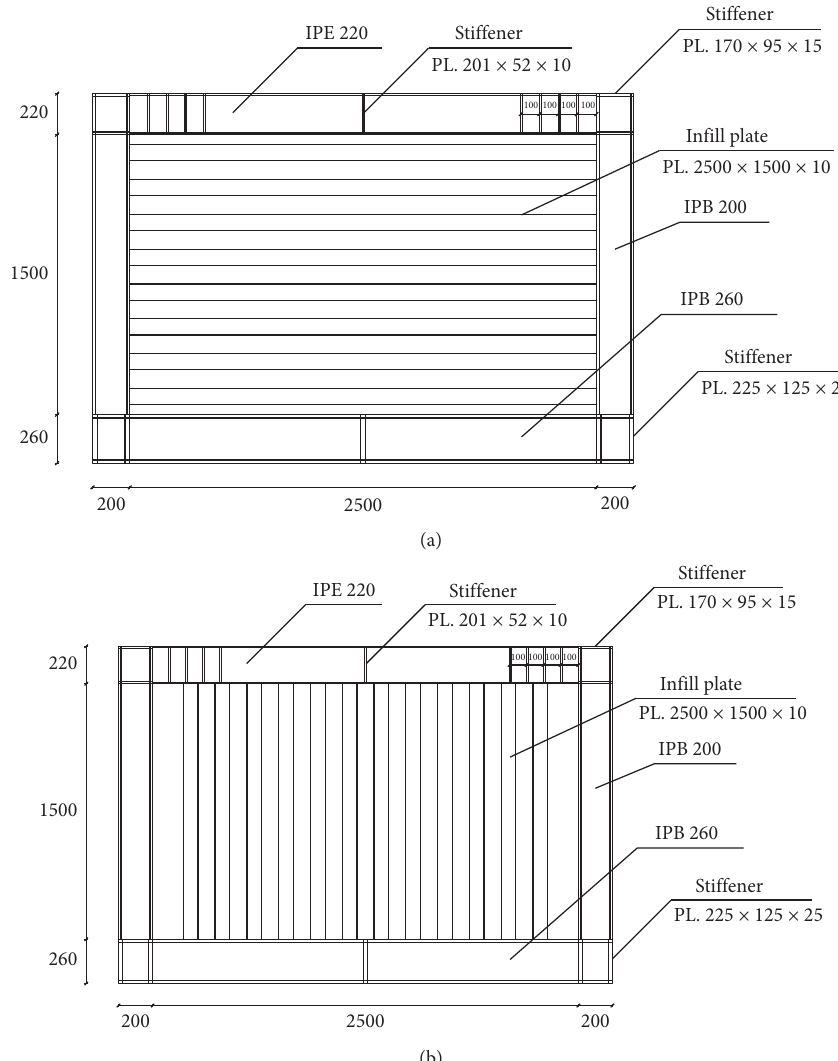
Figure 1: Specimen’s dimensions and member sizes. (a) Horizontal CSPSW. (b) Vertical CSPSW.